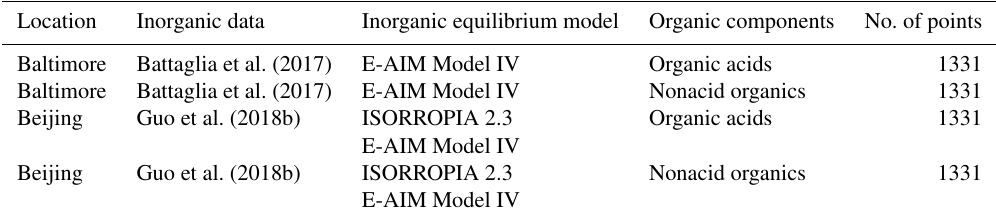
Table 1. Summary of model runs performed for the study. Inorganic composition is invariant and taken from the sources provided. Organic components were added in factorial